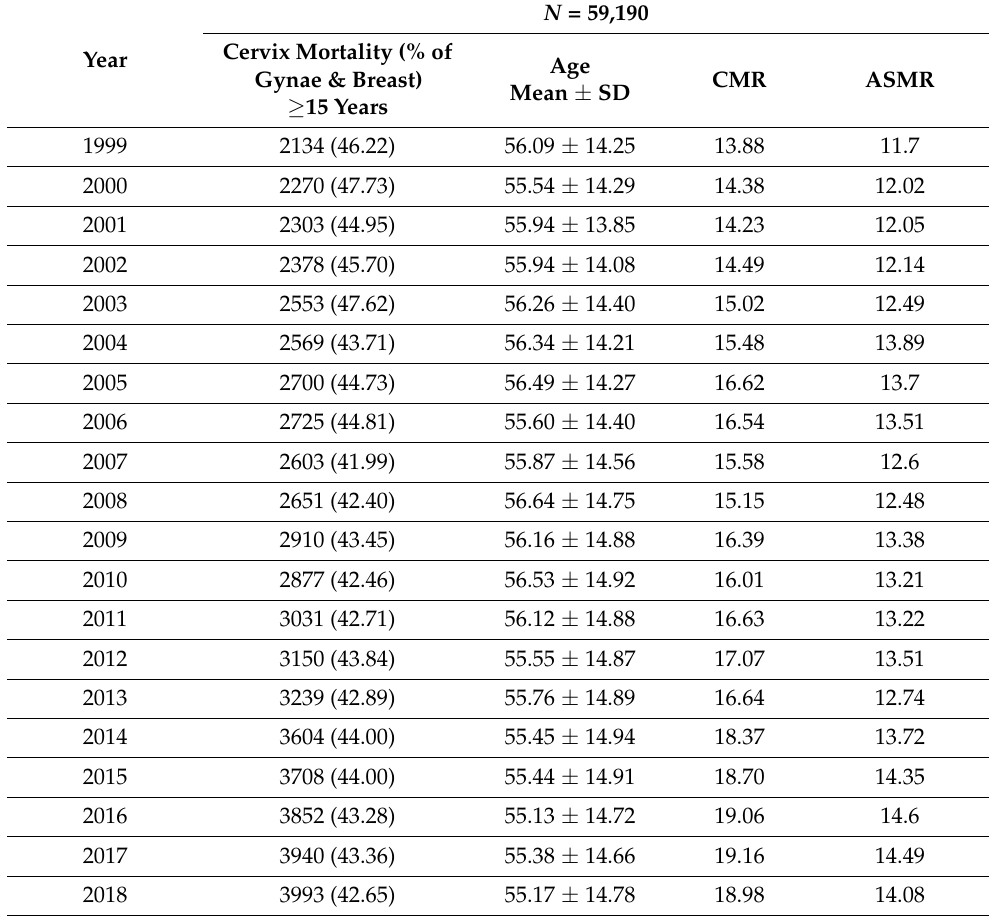
Table 1. Trends in the mortality rates and mean age at death of cervical cancer in South Africa